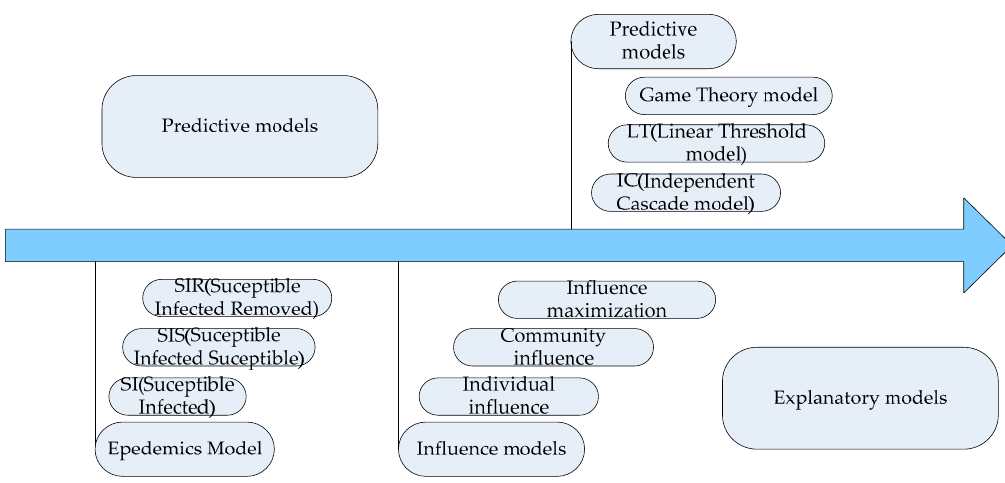
Figure 1. Research Roadmap on Information Diffusion.